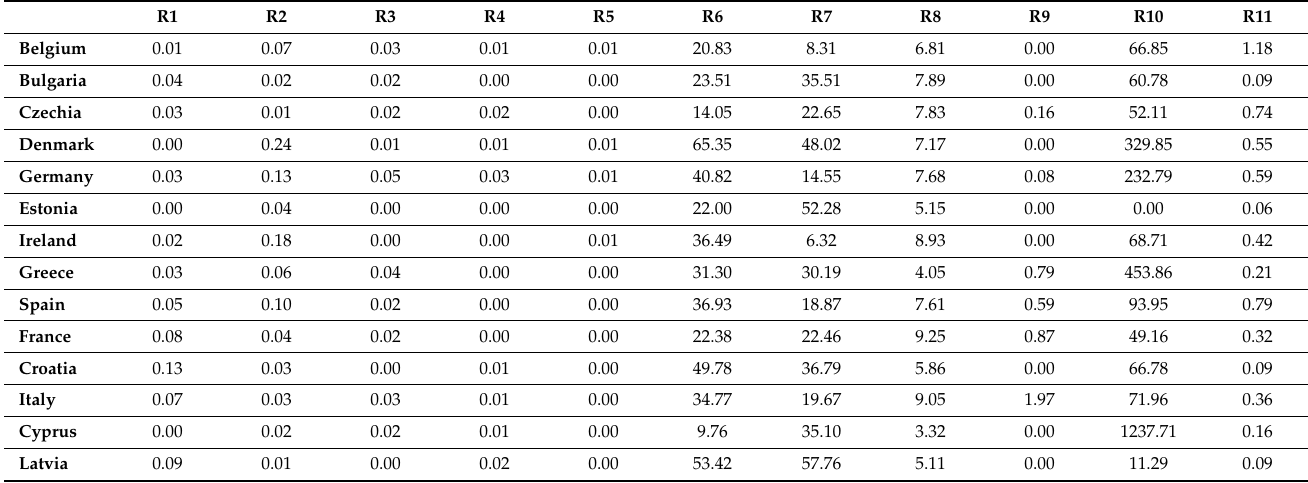
Table A3. Data on the level of development of renewable energy